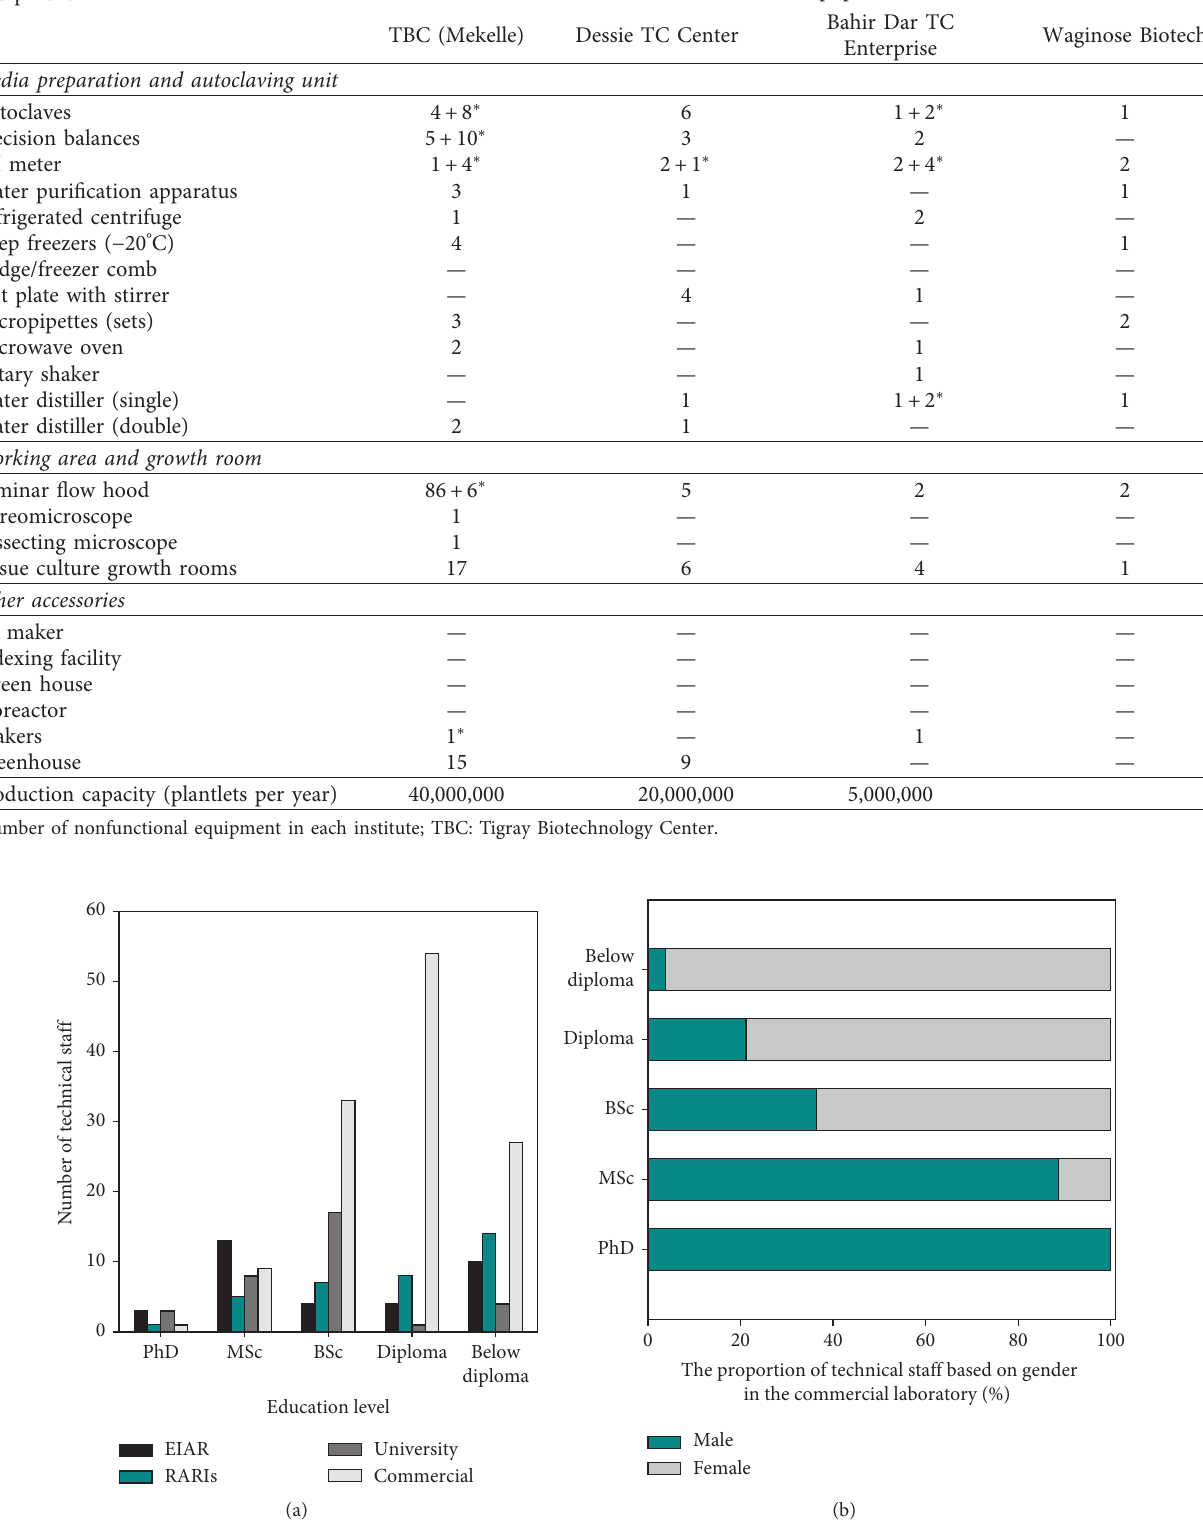
Figure 2: Status and distribution of PTC technical staff in different laboratories. (a) The number of technical staff in currently active PTC laboratory based on education status. (b) Gender proportion of plant TC technical staff in commercial